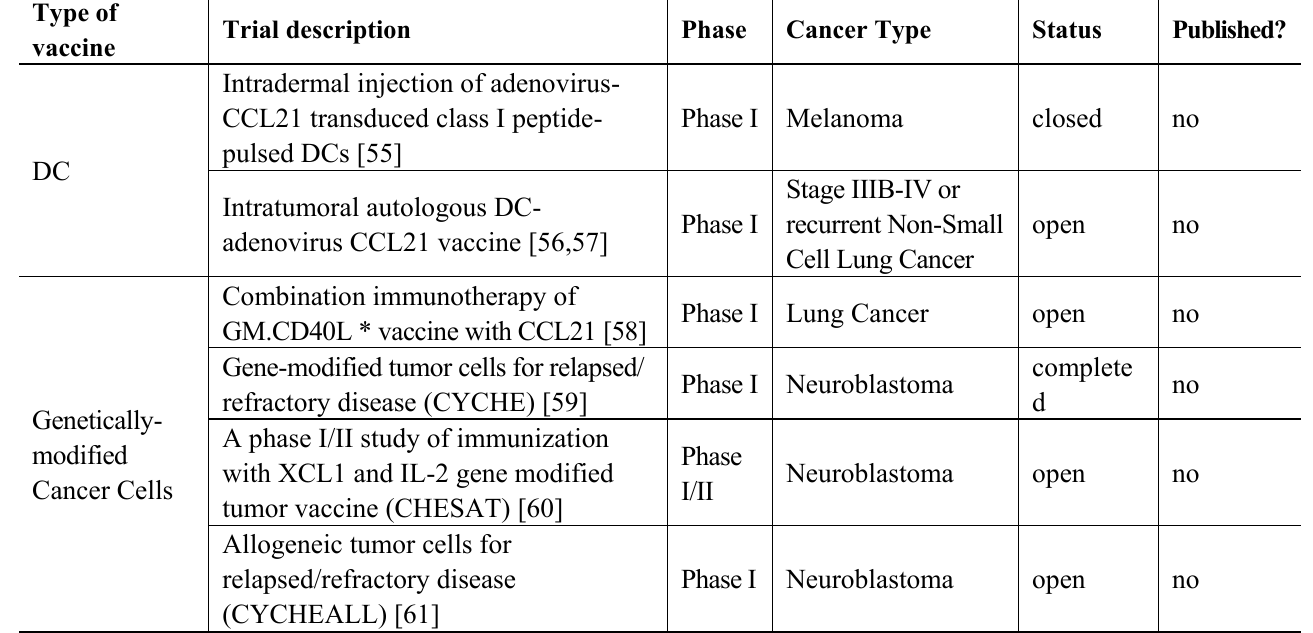
Table 3. Clinical trials using chemokines as cancer vaccine